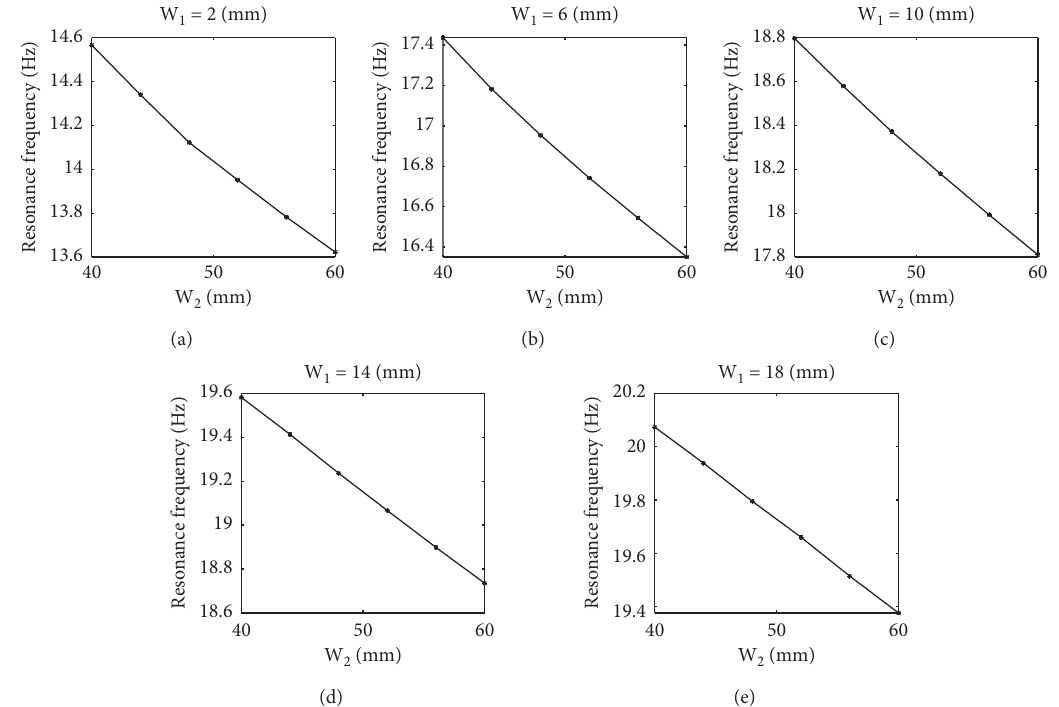
Figure 9: The first resonance frequency vs. 30 permutations of the two-piece trapezoidal piezoelectric composite bimorph cantilever beam (first design). The length of the beam L is 60 mm, the thickness of T piezo is 0.3mm, and the thickness of the brass layer T s is 0.05mm.